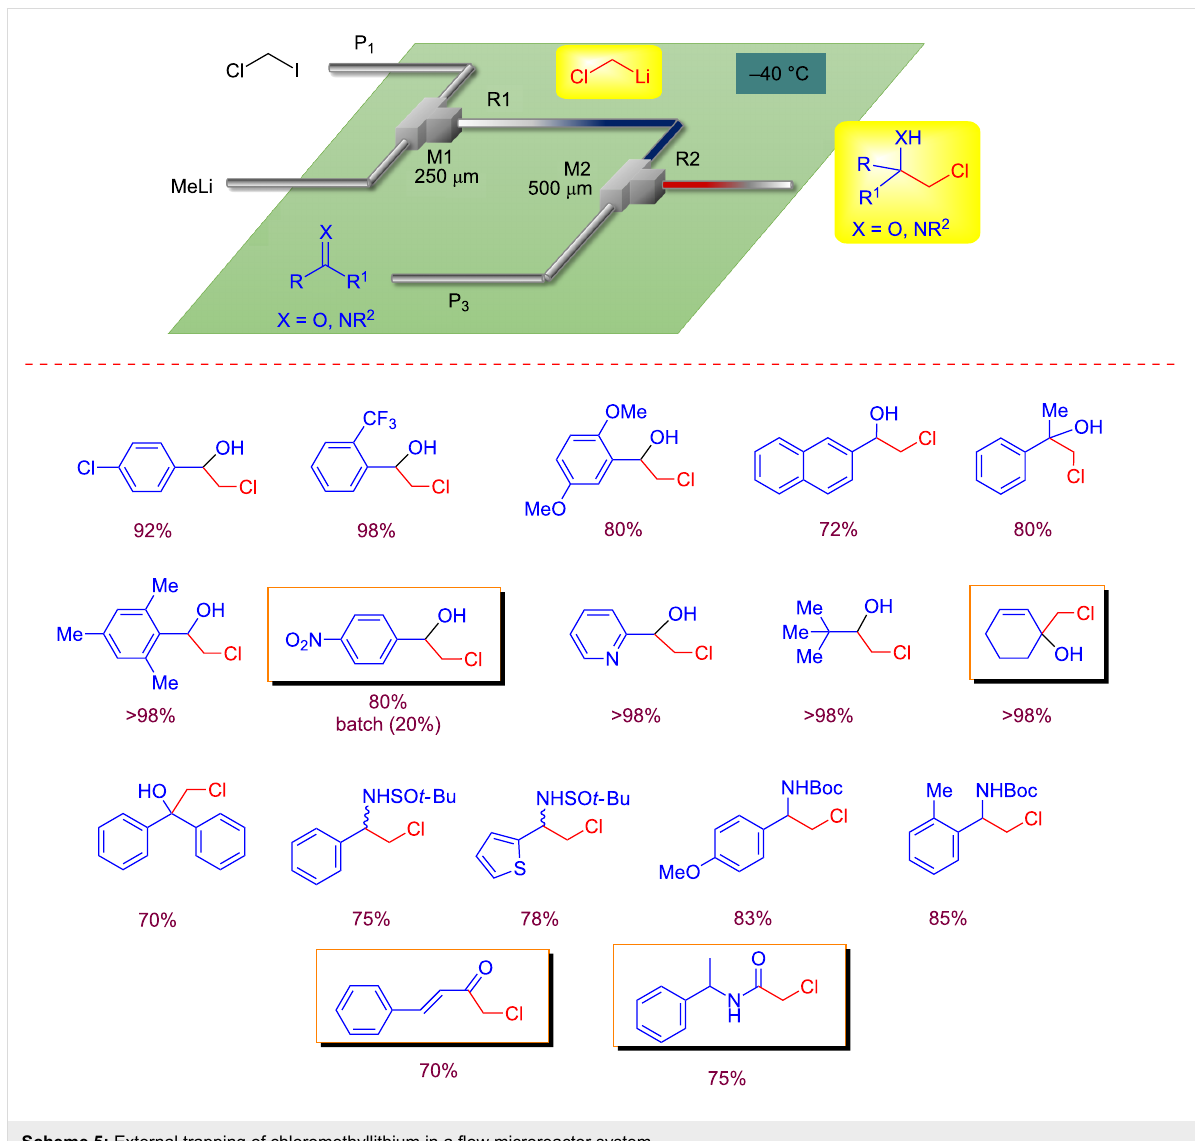
Scheme 5: External trapping of chloromethyllithium in a flow microreactor